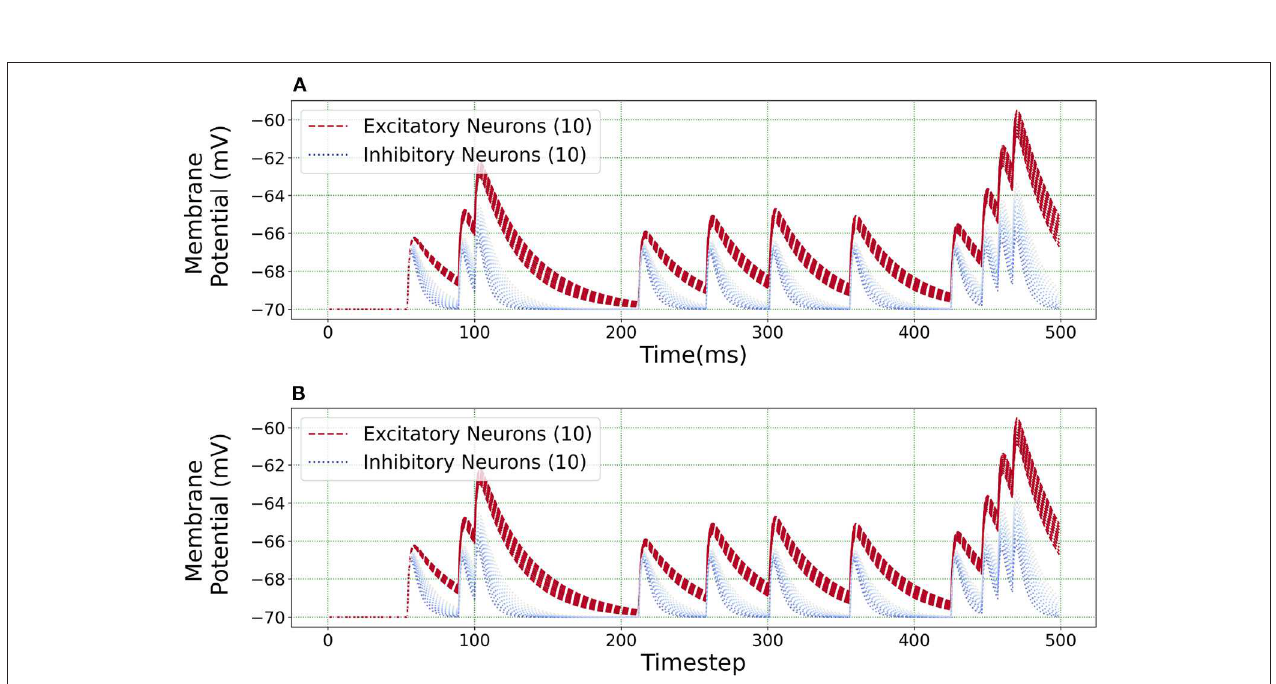
FIGURE 9 | Error comparison for different membrane potential precisions— (A) Membrane potential error. (B) Current error. In both panels, the RMSE for the corresponding state is plotted against the – log of the voltage scale V s .